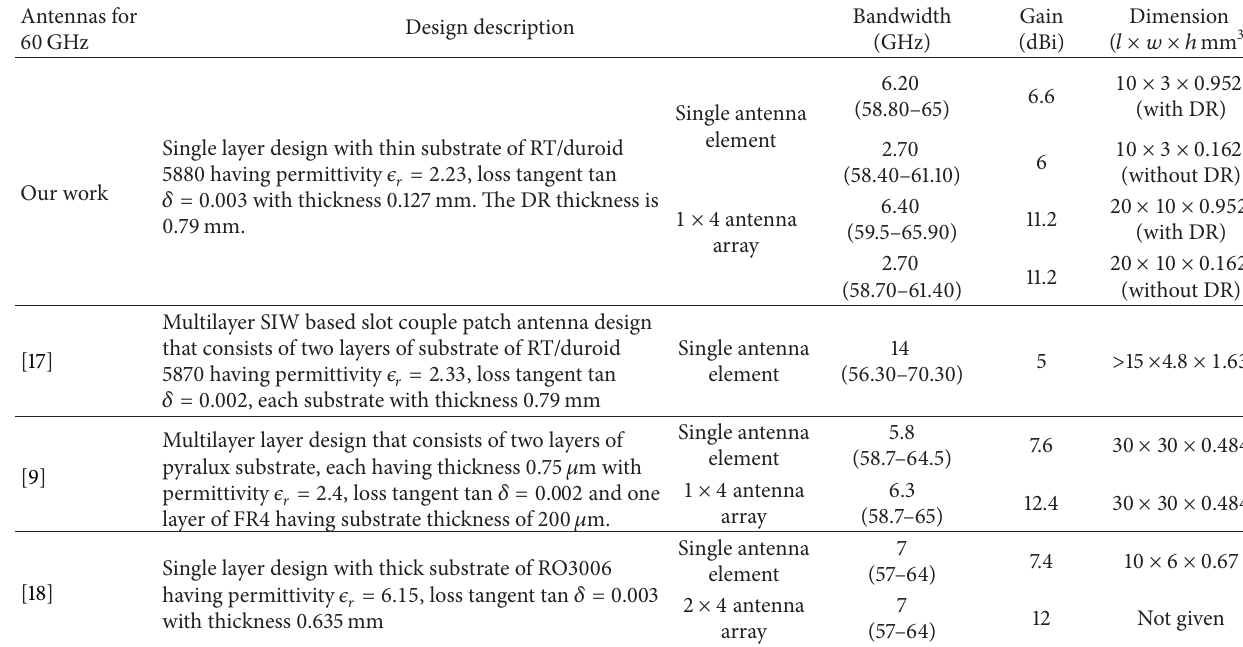
Table 2: 60GHz antenna/array designs and performance comparisons from